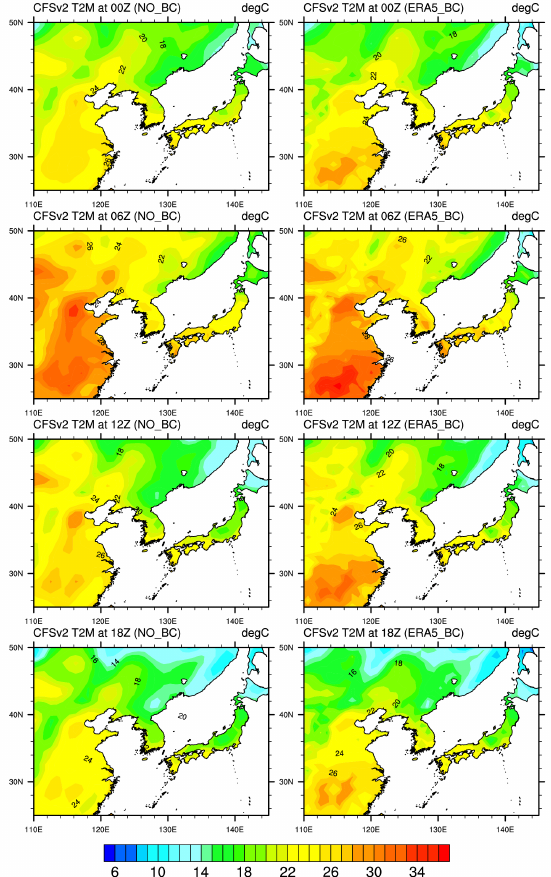
Figure 4. Mean 2 m temperature(NOBC, left) and bias-corrected temperature(right) at 0000, 0006, 0012, and 0018 Z of the CFSv2 initialized during 1800 UTC, 15 June (CASE